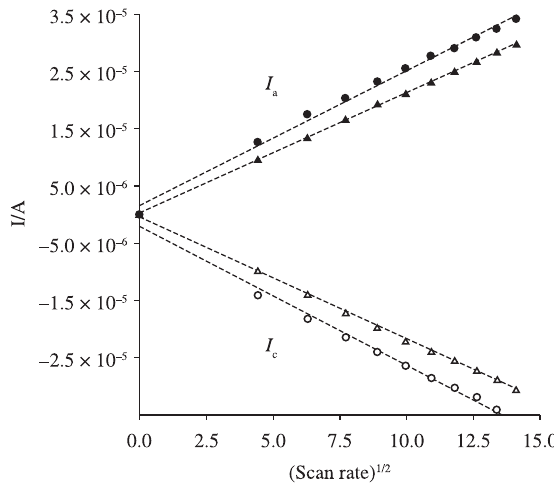
Figure 2. Cyclic voltammograms of 8.0 × 10 –5 mol.L –1 DA at Cys-MGC, Nafion-GC and bare GC electrodes. Scan potential from –0.4 to 1.0 V and scan rate: 50 m.V/s. Supporting electrolyte: PBS (pH = 6).